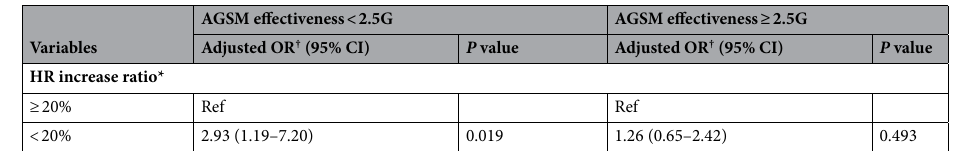
As illustrated in Table 4, multivariate logistic regression indicated an elevated adjusted odds ratio (OR) for an older age [OR 1.99; 95% confidence interval (CI) 1.61–2.46] as well as a BMI of less than 21 kg/m 2 (OR 2.02; 95% CI 1.12–3.64). As expected, AGSM effectiveness in the GOR profile was a predictor of the outcome of 9G profile training. Subjects with an AGSM effectiveness of less than 2.5G had a 2.14-fold higher likelihood of fail- ing in the 9G profile than did those with an AGSM effectiveness of more than 2.5G. In addition, trainees with an increase in HR of less than 20% from 1–5 s also had an increased odds of 9G profile intolerance (OR 1.83; 95% CI 1.09–3.07). Table 5 further describes the impact of the HR increase ratio on the dependent outcome stratified by AGSM effectiveness after adjustments for the confounder. In the group with an AGSM effectiveness of less than 2.5G,